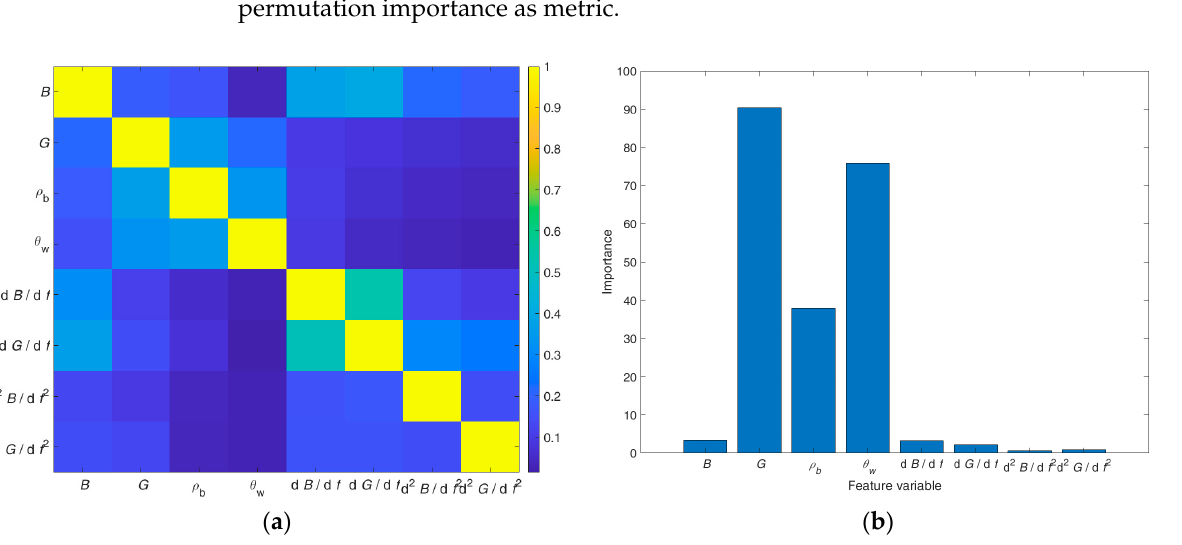
Figure 4. Feature association estimation ( a ) and importance estimation ( b ) using RF, reprinted from Ref. [44].